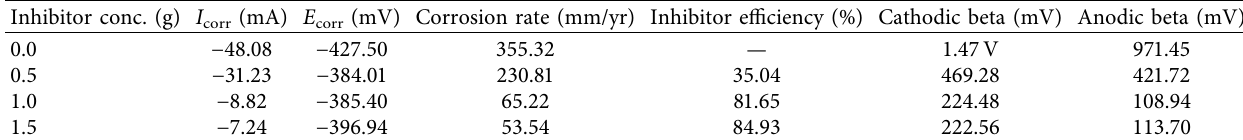
Table 4: Potentiodynamic polarization parameters at 60 ° C.